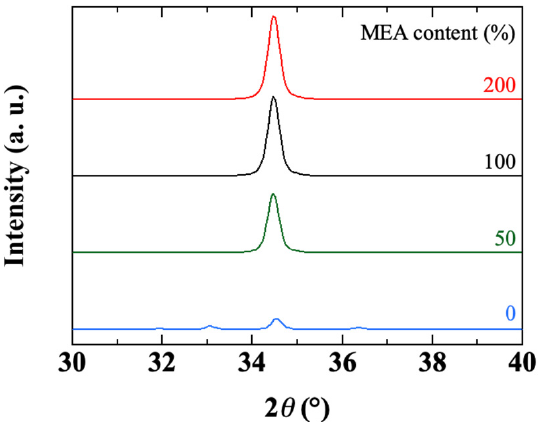
Figure 9. X-ray diffractograms of sol-gel spin-coated ZnO samples obtained with various MEA contents. The thickness of the bulk layer and the roughness layer, deduced from SE the mea- surements, is shown in Figure 10a,b. The absence of a chelating agent (r = 0) reduces the adhesion of the liquid to the substrate during the spin-coating process leading to a very thin film. For MEA content such as 0.5 ≤ r ≤ 2.0, both the bulk layer and the surface roughness keep an almost constant thickness, in the range of 50–70 nm and 5–15 nm, respectively.